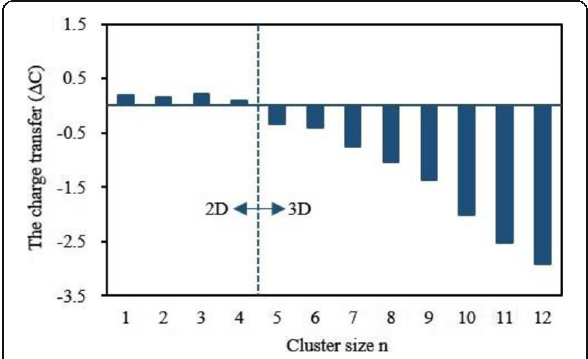
Fig. 9 The charge transfer of V atom in the most stable Ag n V ( n = 1 – 12) clusters. Free V atom as the reference point